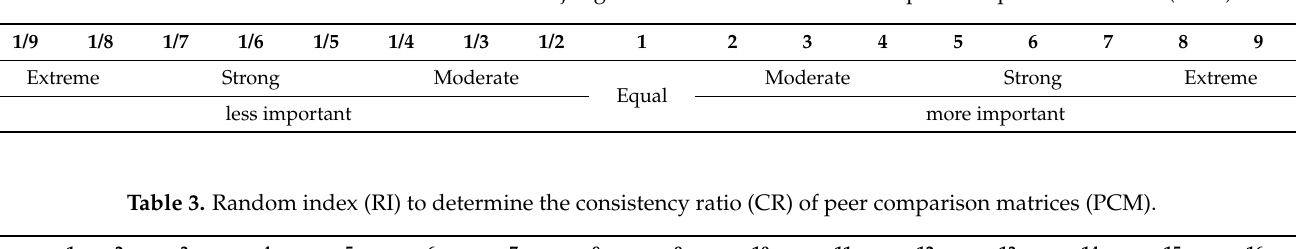
Table 2. Scale established for the allocation of value judgments between two criteria in peer comparison matrices (PCM).